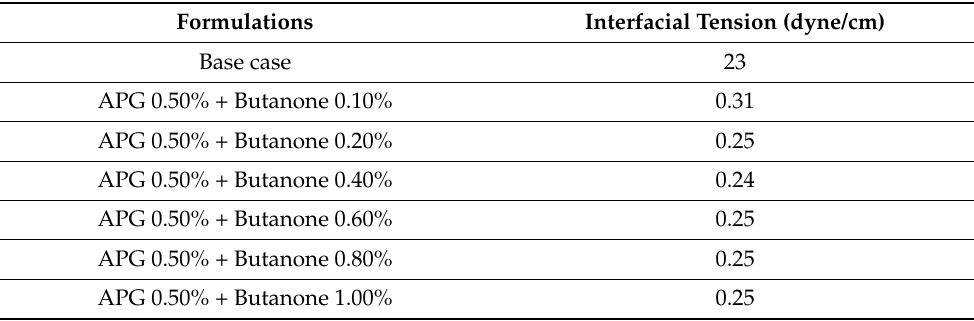
Figure 8. Interfacial tension values for butanone at concentrations ranging from 0.20% to 1.00% with constant APG (0.50%) and brine (2% NaCl) levels at 52 ◦ C and atmospheric pressure. Table 6. Interfacial Tension Values for APG 264 and 0.5% Butanone at Concentrations Ranging from 0.1% to 1.0%.